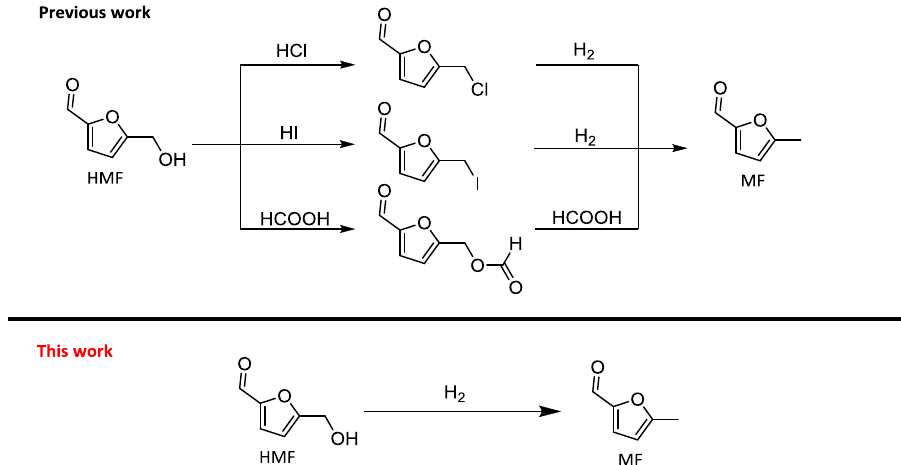
Fig. 1 The synthetic routes to produce MF from HMF. The previous methods to synthesize MF with acid. This work to directly synthesize MF without any